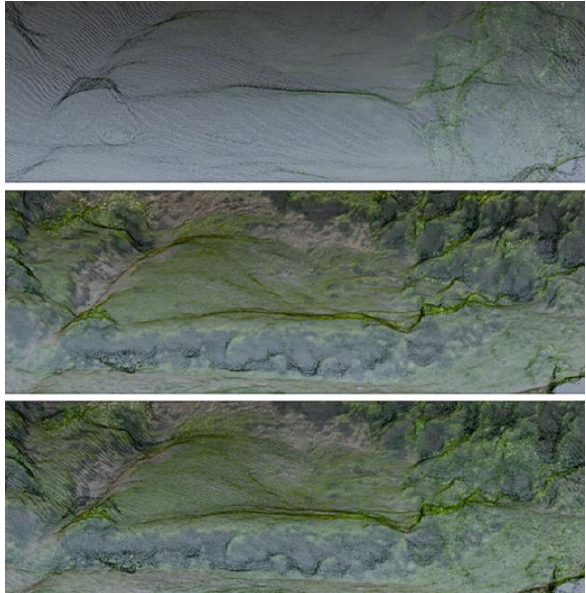
Figure 4. The tools to create a digital survey must be carefully compared to them in order to obtain the correct level of detail necessary for the various research and environmental management